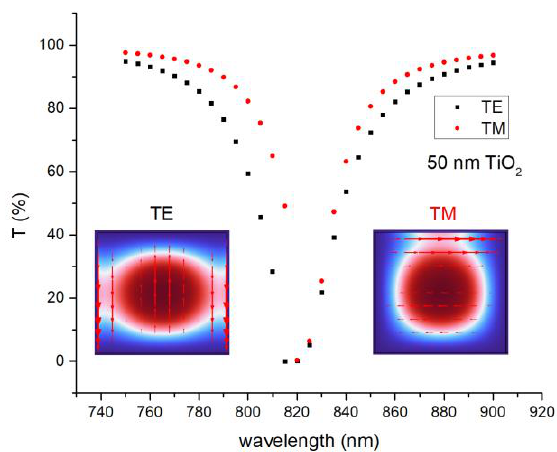
Figure 7. Differences in LMR depending on the polarization of light.